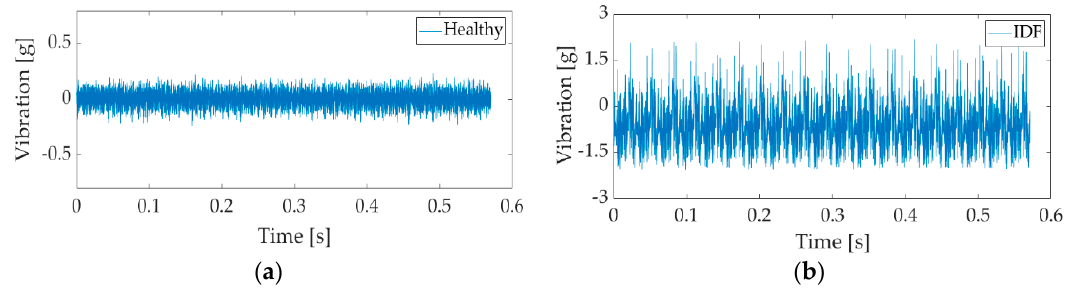
Figure 3. Experimental results of the vibration signal for healthy and faulty machine, ( a ) healthy machine; ( b ) irreversible-demagnetization fault ( IDF).